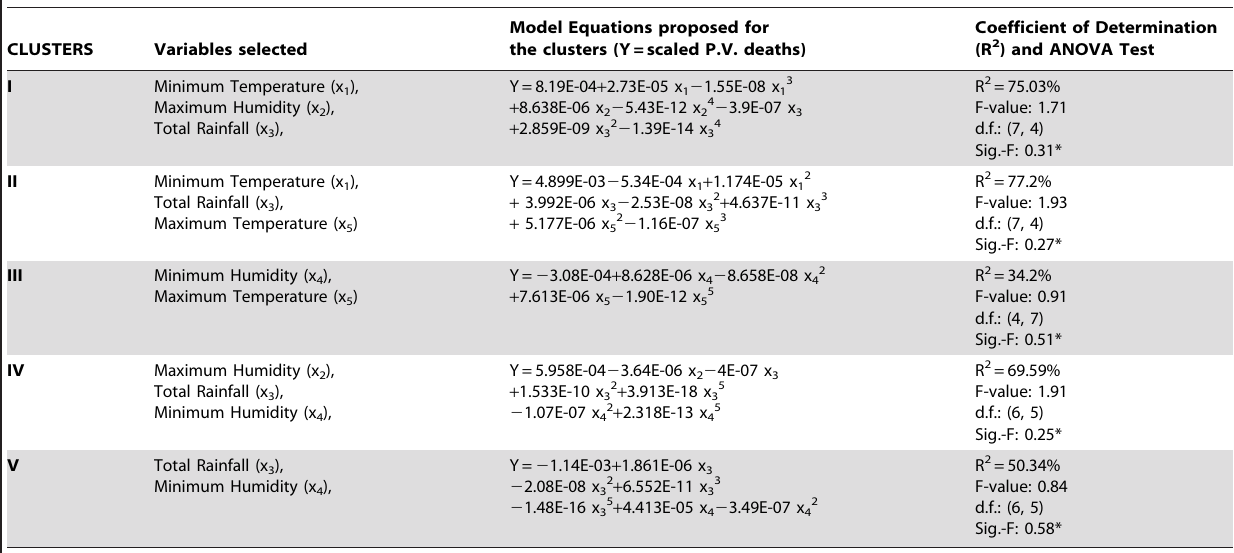
Table 2. The final model fits for individual clusters.